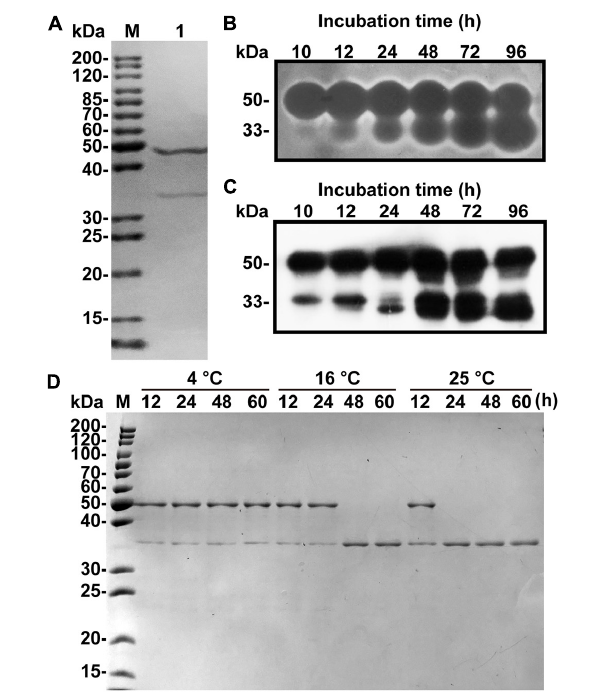
FIGURE 1 | Fermentation, purification and spontaneous cleavage of native VxAly7B. (A) Purified native VxAly7B was resolved by 12.5% acrylamide (w/v) SDS-PAGE and stained with Coomassie Blue R-250. Lane M, molecular weight markers; Lane 1, purified native VxAly7B. (B) Native VxAly7B production is shown by in-gel renaturation. (C) Native VxAly7B production is shown by Western blot. (D) Spontaneous cleavage of native VxAly7B was resolved by